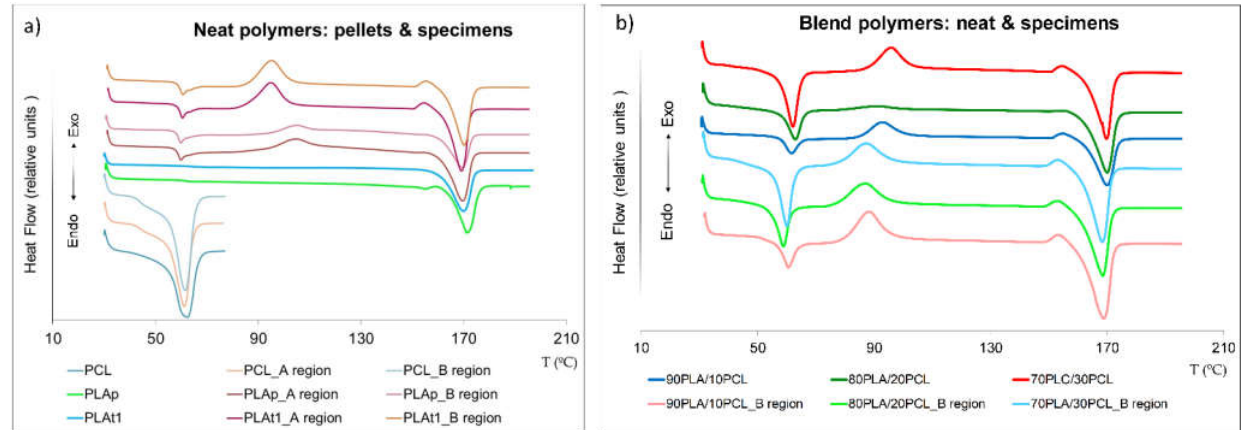
cPLA and ( b ) X cPCL .